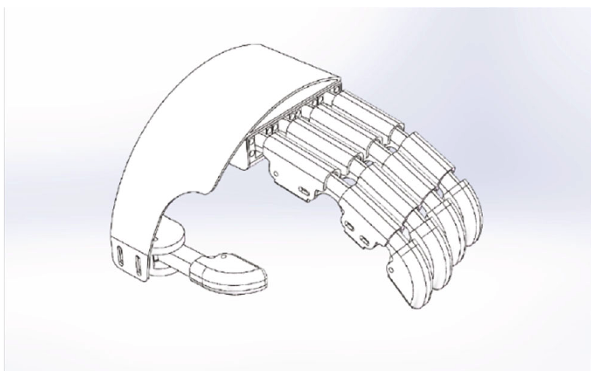
Figure 1: Mechanical structure of the fi nger rehabilitation exoskeleton.